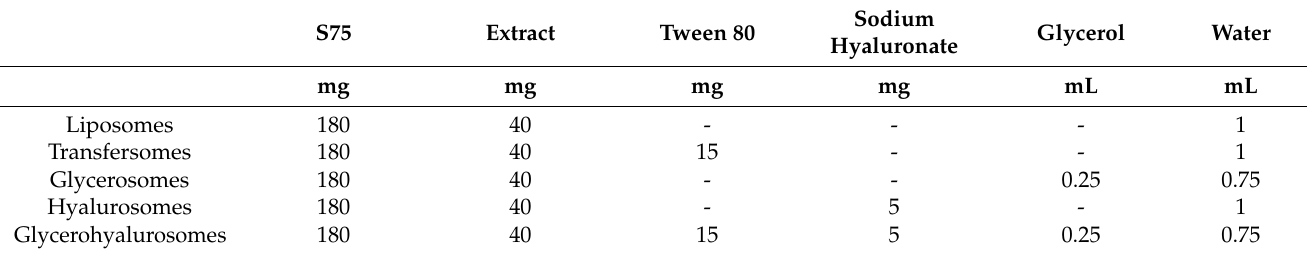
Table 1. Composition of Teucrium marum dried extract loaded